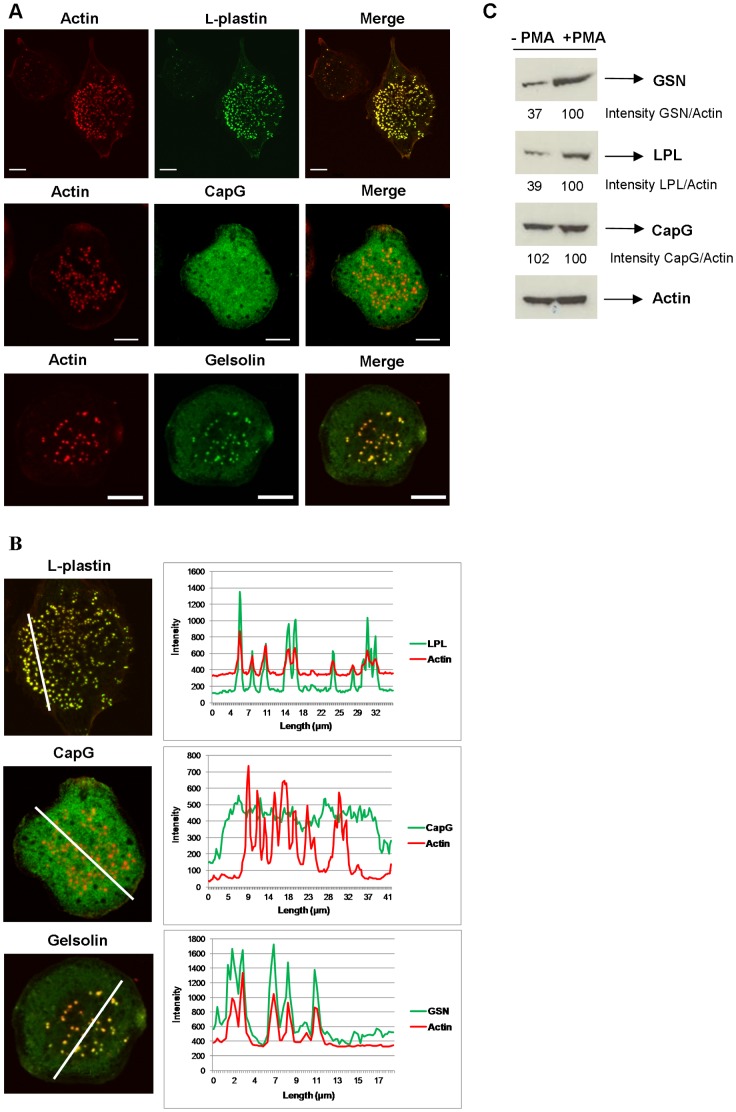
L-plastin and gelsolin localize to podosomes of THP-1 macrophages.(A) Monocytic THP-1 cells were differentiated with PMA for 3 days. Cells were stained for F-actin (phalloidin-alexa 594, red) and L-plastin, gelsolin or CapG (alexa-488, green). The pictures were acquired with a laser scanning confocal microscope and are representative for three independent experiments. Bar: 10 µm. (B) Graph of the F-actin and LPL/CapG/GSN intensities measured along the line, drawn across the (podosomes of the) cell. Intensity profiles were represented as function of the length (µm) of the line. (C) Lysates of PMA-stimulated versus –unstimulated THP-1 cells were blotted and probed for L-plastin, CapG, actin or gelsolin. Blots are representative for two independent experiments. Densitometry was used to determine band intensity in (C) and is expressed as GSN:actin, LPL:actin and CapG:actin.